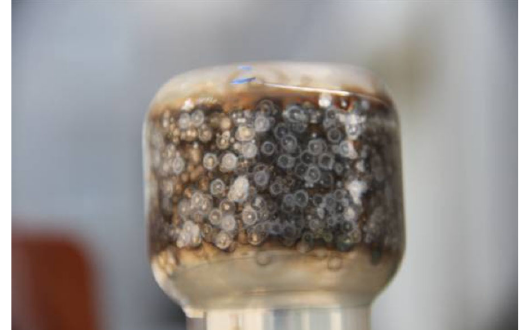
FIG. 8. Electric fields distribution of charging and triggering time. FIG. 9. Electrode ablation